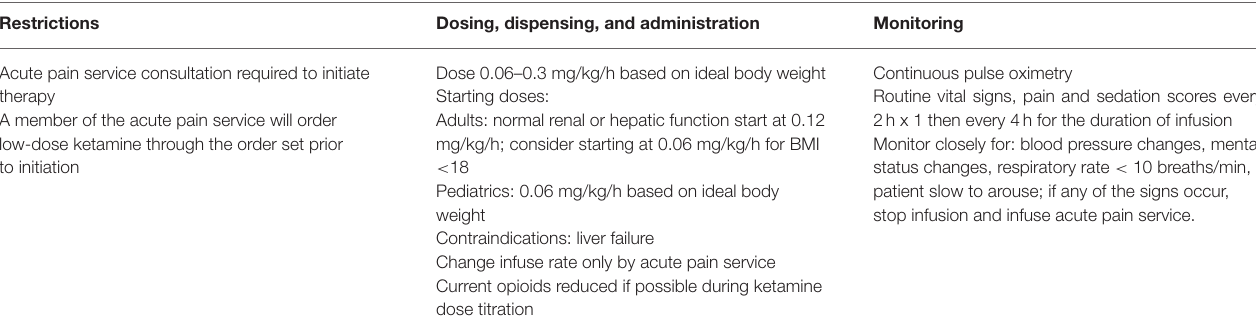
TABLE 2 | University of Chicago inpatient ketamine infusion